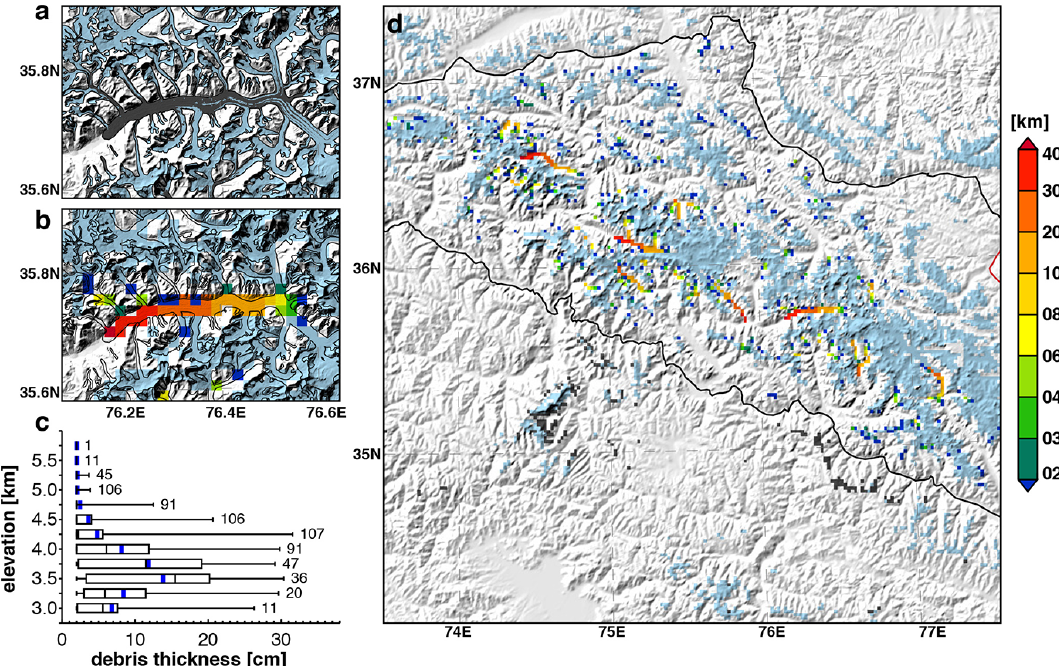
Figure 2. (a) Debris-covered (gray) and debris-free (blue) glacier areas, calculated on a 40m grid for the Baltoro glacier and surrounding areas. The distance down-glacier over debris-covered areas, which is multiplied by a fixed gradient to map debris, is shown for (b) the Baltoro glacier and (d) the entire WRF-D3 region. In (d) , the black contour delineates the region where centerline information was available from (Rankl et al., 2014). Outside of this region, distance down-glacier was not computed and debris-covered areas are shaded in gray to indicate these data are missing. (c) A box plot of debris thickness values, assuming a fixed gradient of 0.75cmkm − 1 and averaging in 250m elevation bins over WRF D3. The thick blue and thin black lines indicate the mean and median thicknesses in each bin. The total number of debris-covered pixels is given as a text string at the upper end of the